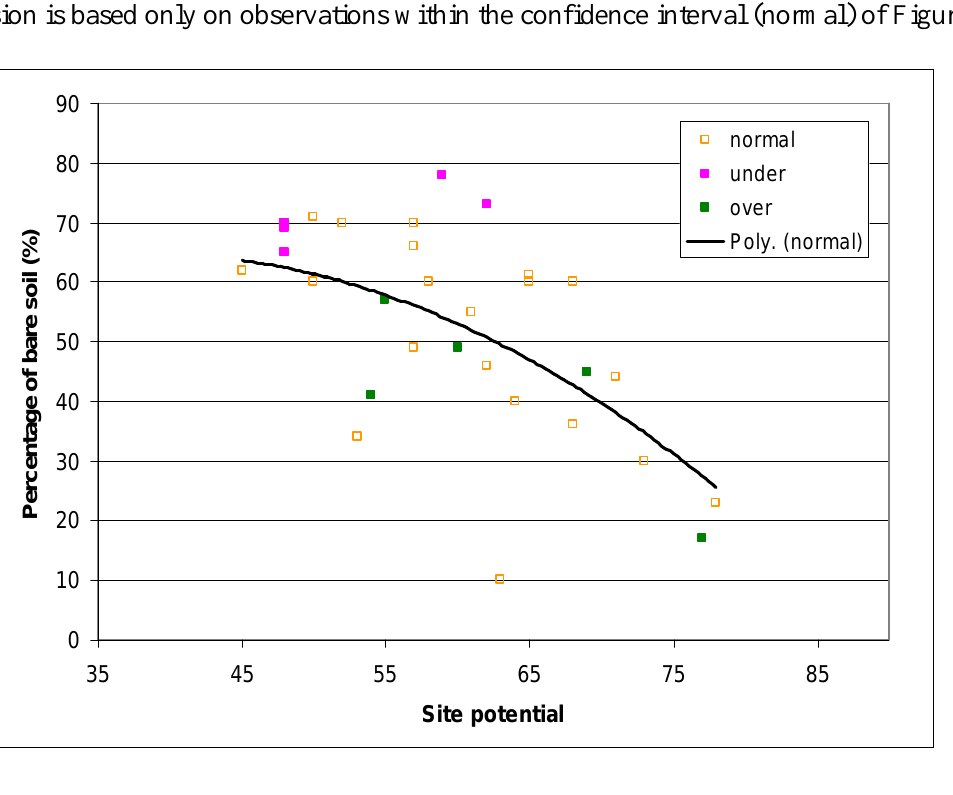
Figure 7. Ecosystem performance anomaly (EPA) validation for big sage in the UCRB using “percentage of bare soil” ground observations from multiple research projects which represented smaller footprints than 250 m. Regions identified as persistently underperforming (pink) tended to have a higher percentage of bare soil, and regions identified as overperforming (green) tended to have a lower percentage of bare soil. The regression is based only on observations within the confidence interval (normal) of Figure